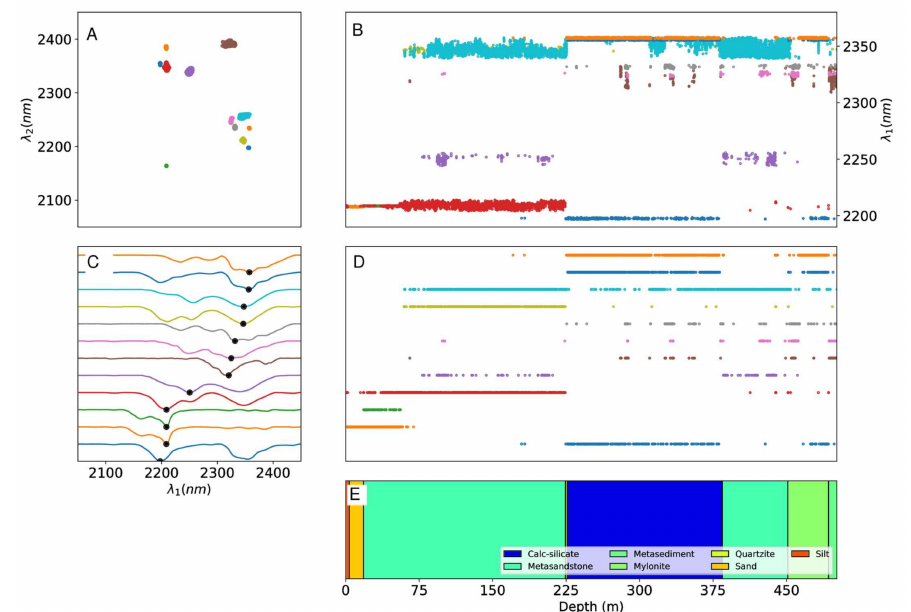
Figure 7. The 1st and 2nd deepest wavelength location of the extracted features in the 2050–2450 nm spectral region of the MSDP13 dataset ( A ), the down hole deepest feature as a function of hole depth ( B ). ( C ) shows the calculated MSR assemblages for each of the clusters in the top-left while the ( D ) plot shows the down hole distribution of those assemblages and ( E ) is the geologists logged litholgy. See the text included in the Results Section for a more detailed explanation of the individual plots.